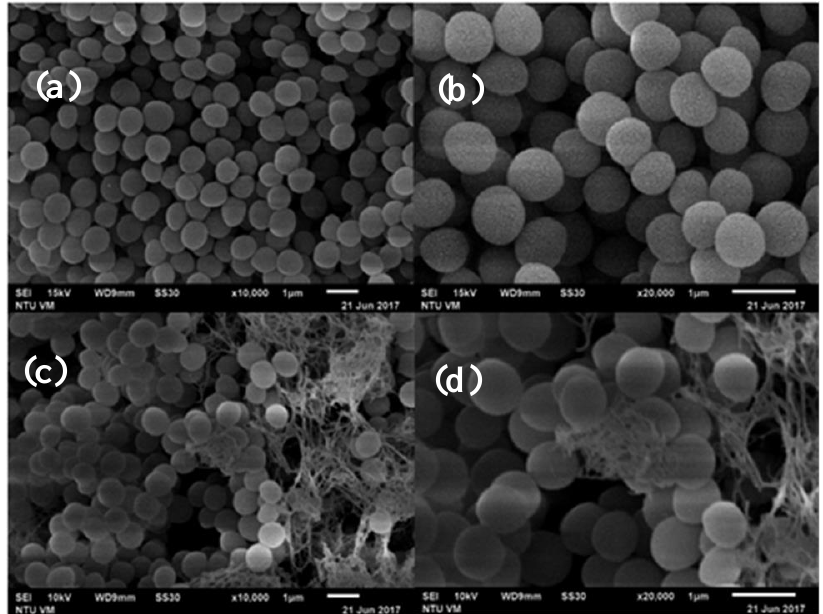
Figure 6. SEM micrographs of Staphylococcus capitis cells in phosphate buffer. ( a ) and ( b ) Untreated cells; ( c ) and ( d ), cells treated with 500 MPa for 10 min.